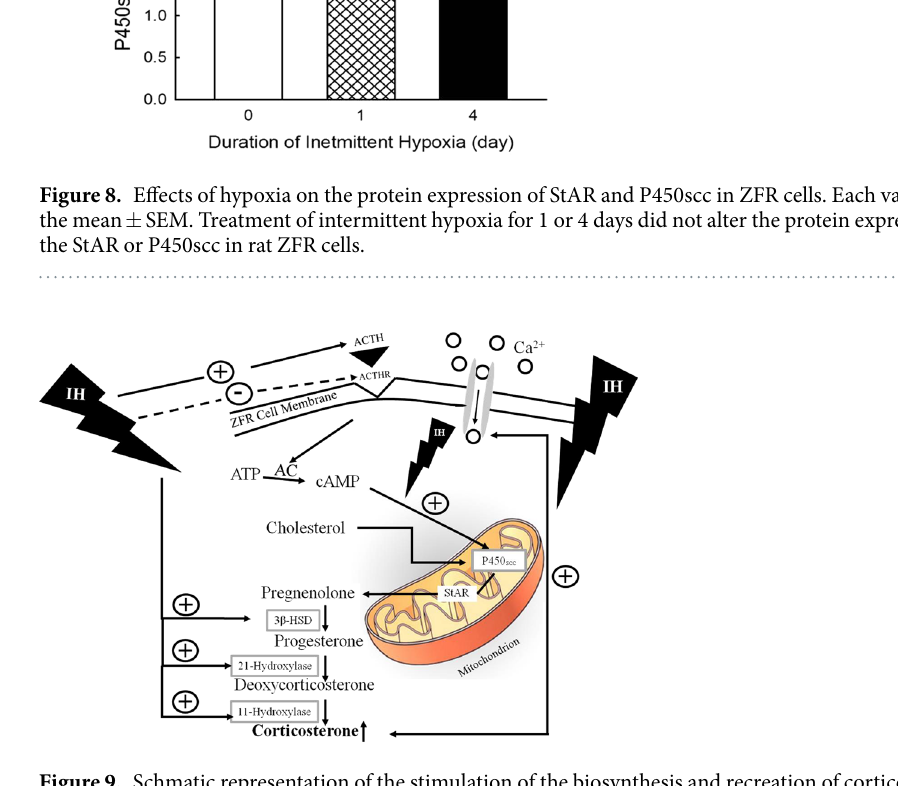
Figure 9. Schmatic representation of the stimulation of the biosynthesis and recreation of corticosterone by intermittent hypoxia in rat ZFR cells. IH, intermittent hypoxia; ACTH, adrenocorticotropin; StAR, steroidogenic acute regulatory protein; 3 β -HSD, 3 β -hydroxysteroid dehydrogenase; ZFR cells, zona-fasciculata- reticularis cells. The solid line represents stimulation. The dash line represents